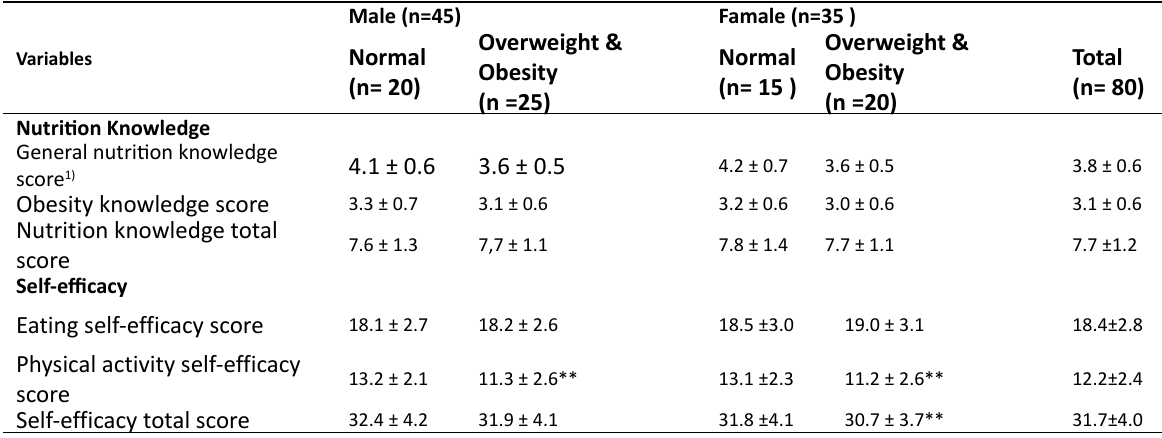
Table 4: Nutritional knowledge and self-efficacy levels according to obesity status in Sedanter Individuals who are Members of Fitness